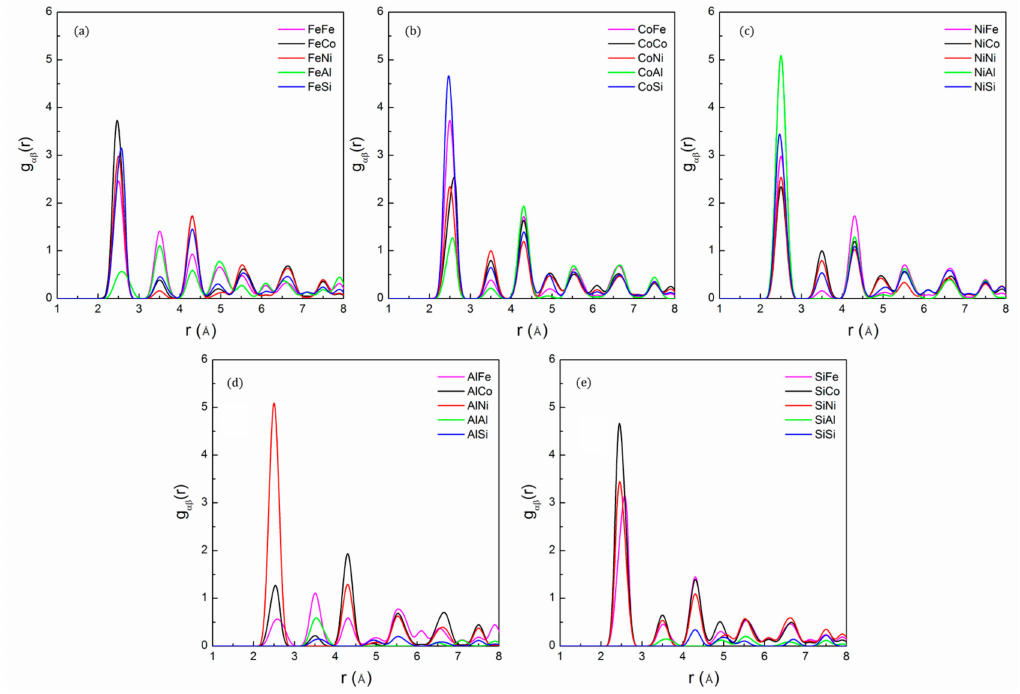
Figure 3. The partial pair distribution function for: ( a ) Fe; ( b ) Co; ( c ) Ni; ( d ) Al and ( e ) Si of FeCoNi(AlSi)